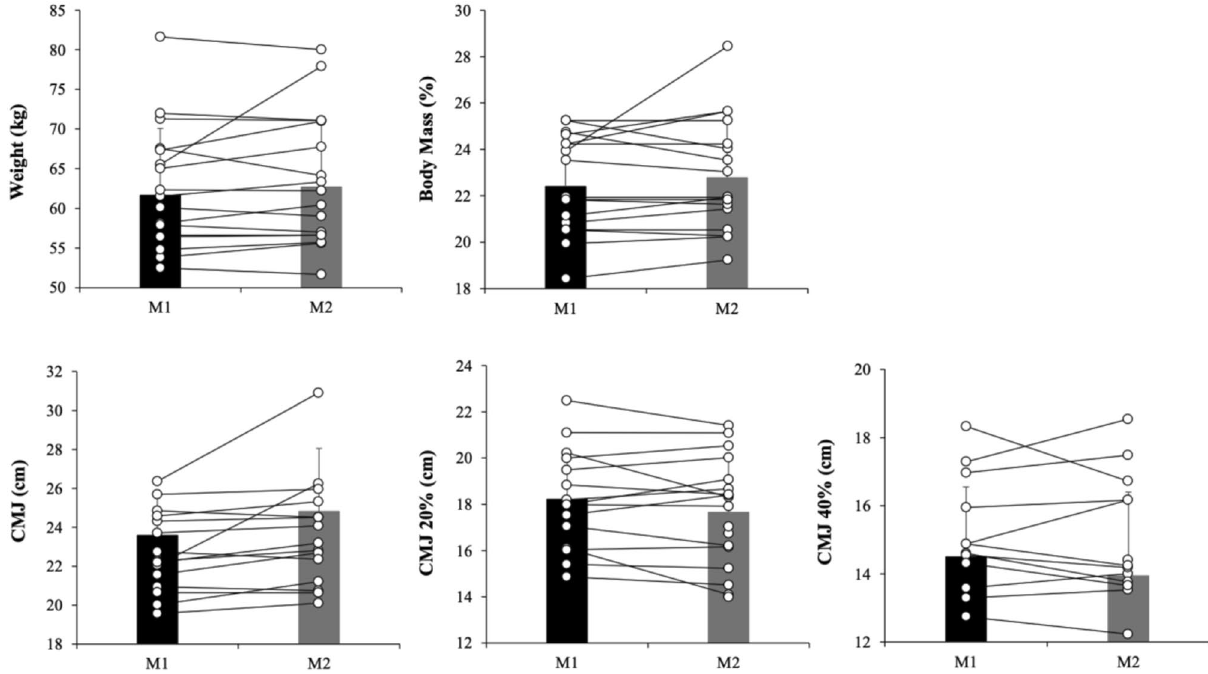
Figure 2. Performance variables (anthropometric measurements and countermovement jump) in moment 1 (M1) and Moment 2